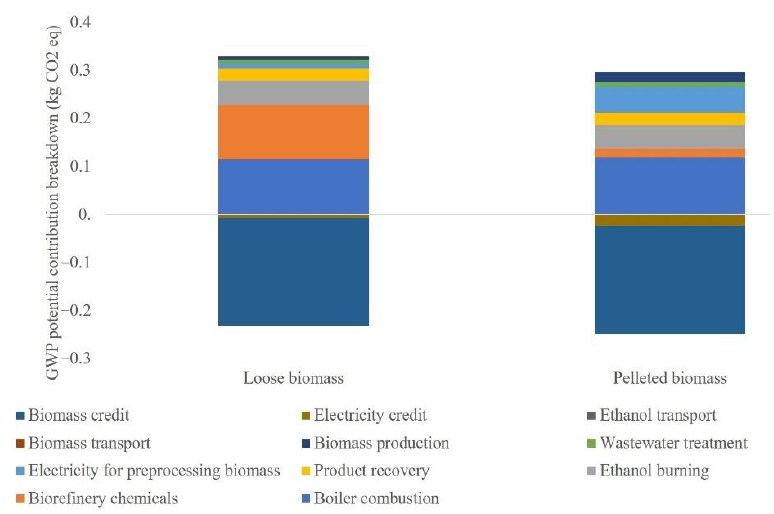
Figure 7. Emission breakdown for 1 MJ ethanol from loose and pelleted biomass.